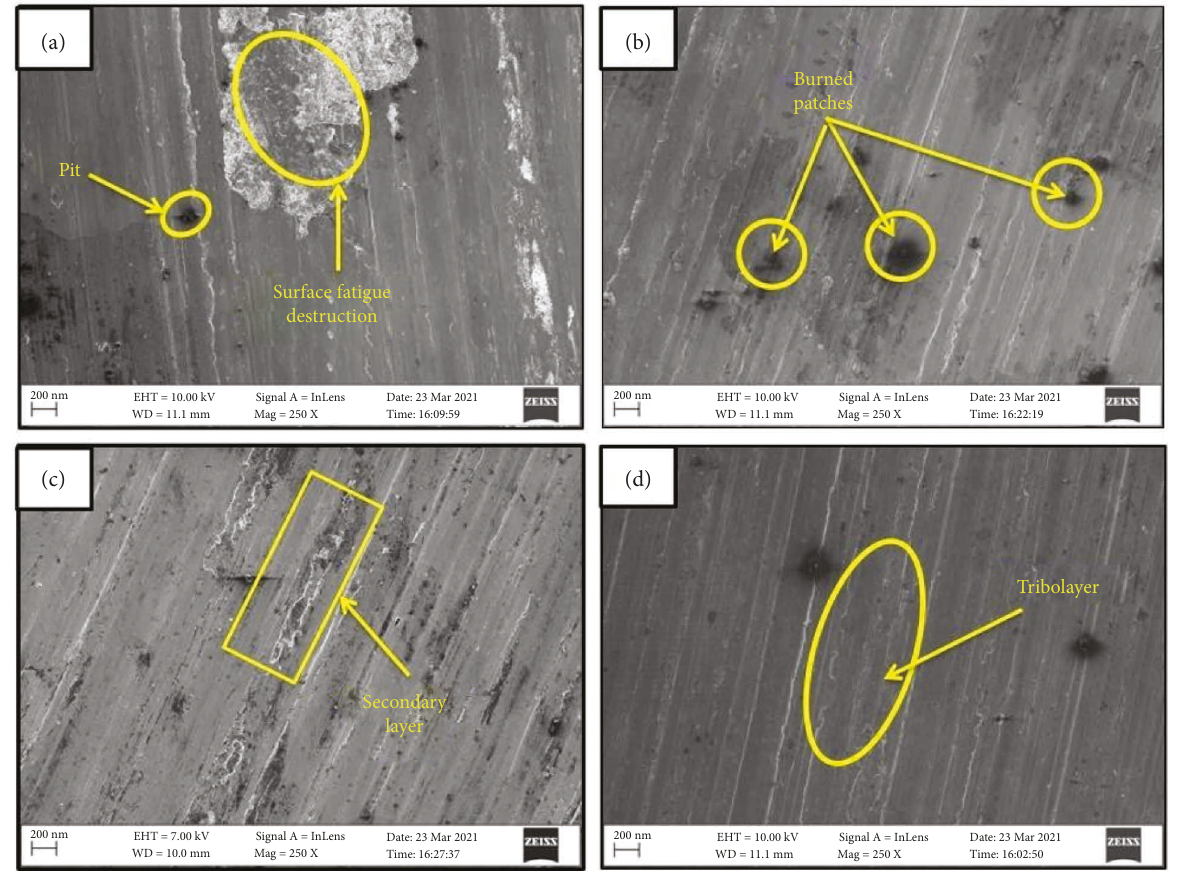
Figure 12: Worn surface of AA7075/9 wt. (%) composites at the applied load of (a) 10N, (b) 20N, (c) 30 N, and (d)